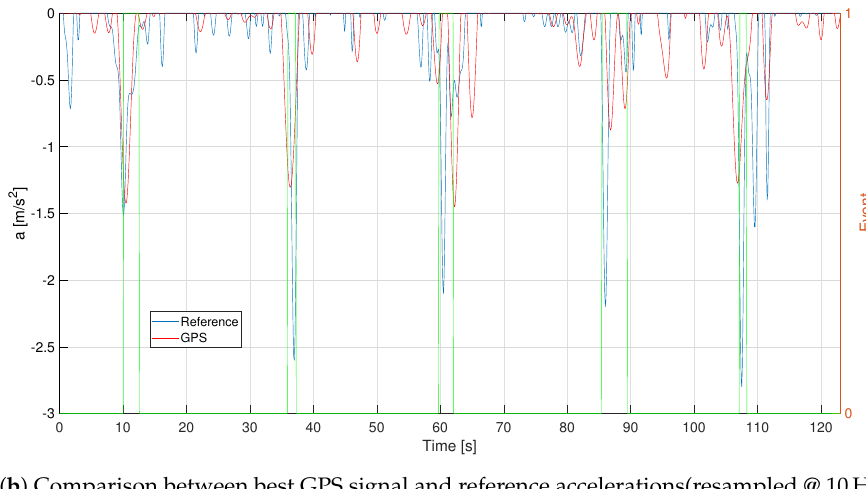
Figure 13. C1—Distance analysis results for GPS. Events are reported as pulsed train (green solid line).